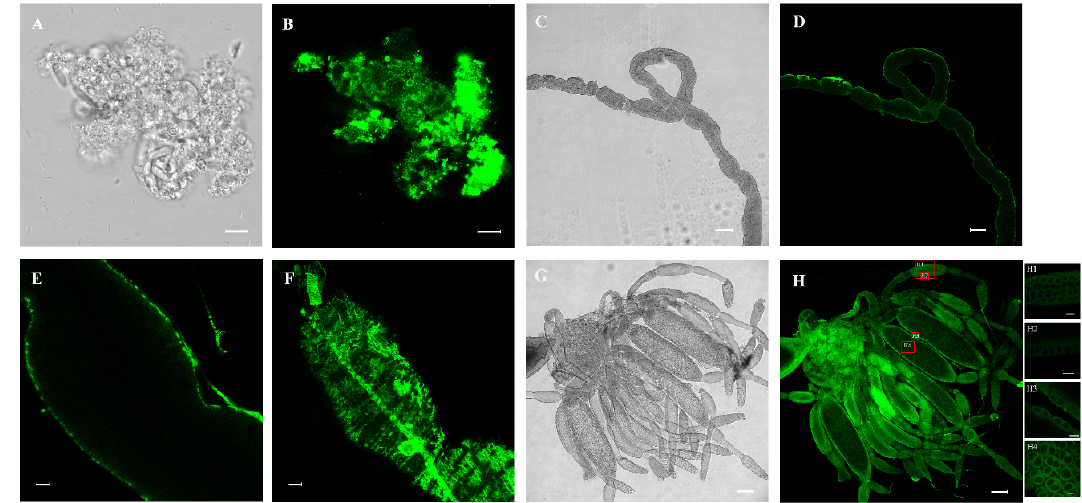
Figure 5. Analysis of Nl PCE3 expression using immunofluorescence staining. ( A – B ) The localization of Nl PCE3 in fat body. ( C – F ) The localization of Nl PCE3 in gut. ( D – H ) The localization of Nl PCE3 in ovary. H1 to H4 were respectively enlarged from H (red boxes). Scale bar: 10 μ m ( A – B , E – F , H1–H4 ); 100 μ m ( C – D , G – H ).